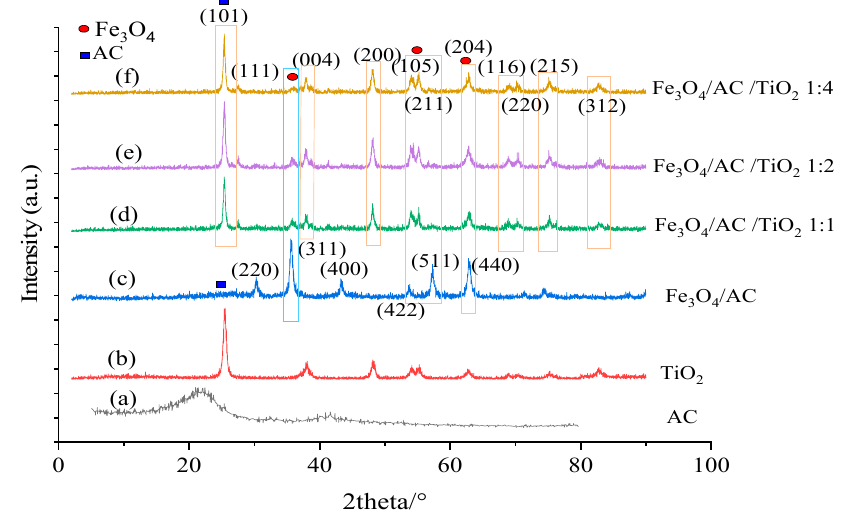
Figure 1. XRD patterns of AC ( a ), TiO 2 ( b ), Fe 3 O 4 / AC ( c ), Fe 3 O 4 /AC/TiO 2 prepared at different ratios of 1:1 ( d ) to 1:2 ( e ) and 1:4 ( f ).